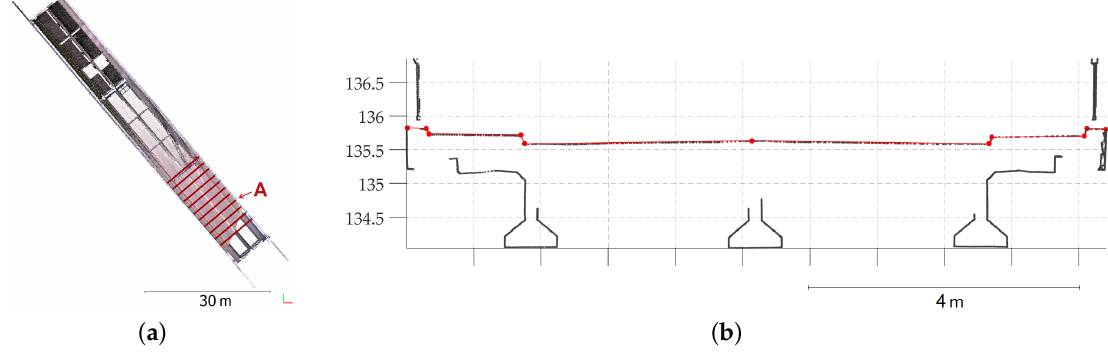
Figure 8. ( a ) Top view of the bridge point cloud with locations of the investigated sections (red lines); ( b ) Section A performed in Trimble SX10 point cloud and displayed together with the tacheometric profile data (in